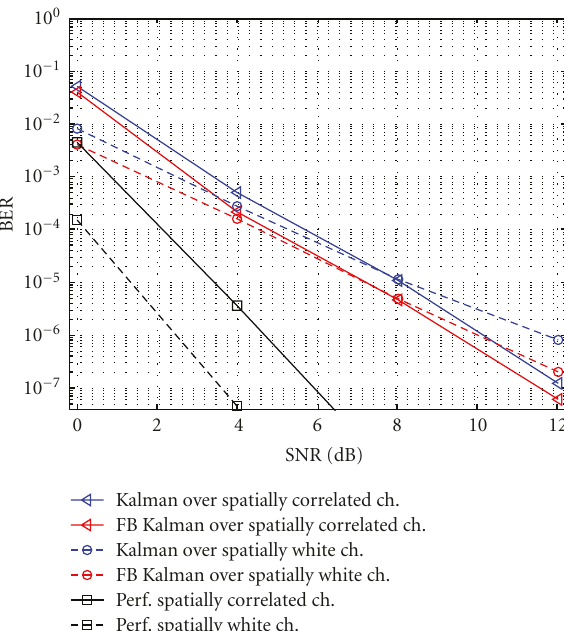
Figure 9: BER performance of Kalman and FB -Kalman using soft data over spatially white and correlated channel